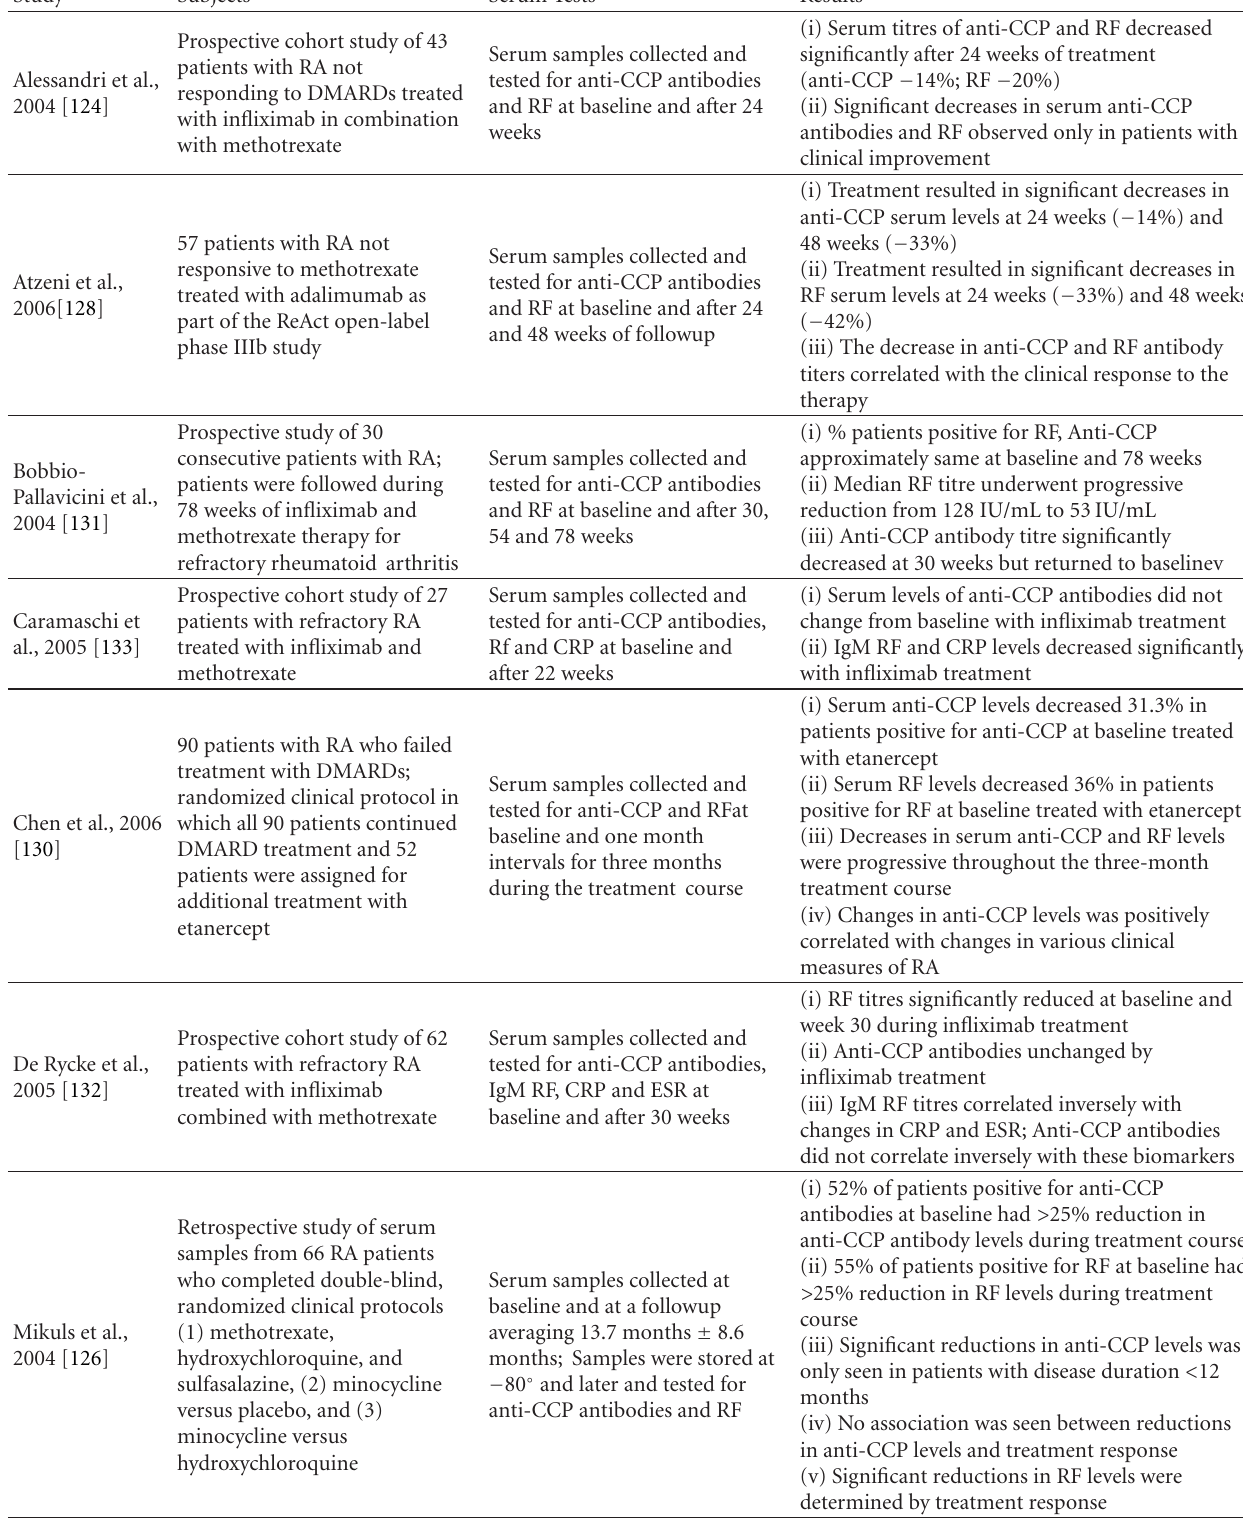
Table 4: Studies of anti-CCP and RF levels following treatment for